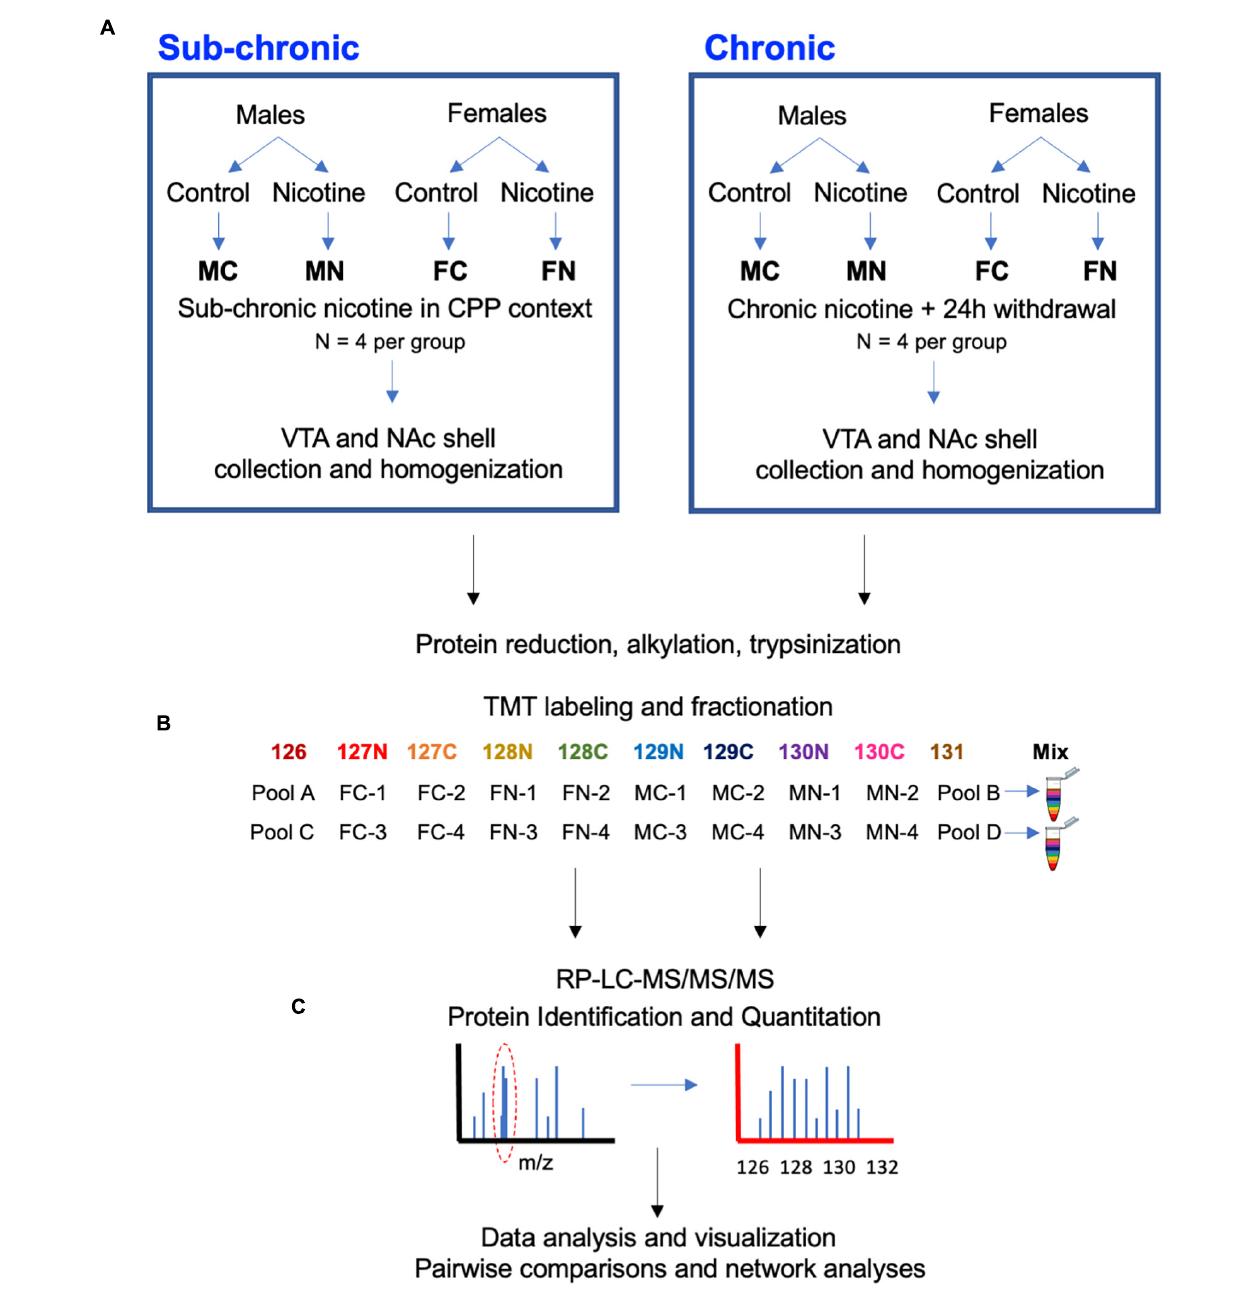
FIGURE 1 | Experimental design and workflow. (A) Male and female mice were treated with nicotine or control solutions. In C3H/HeJ mice, sub-chronic nicotine or saline was administered subcutaneously on alternating days for a total of 6 days in a CPP testing paradigm ( n = 4 per group). In C567BL/6J mice, nicotine or saccharin was administered in drinking water chronically for 21 days, followed by a 24-h withdrawal period ( n = 4 per group). About 10–30 min after CPP testing in C3H/HeJ mice, or 24 h after cessation of nicotine or saccharin treatment in C57BL/6J mice, subjects were sacrificed and the VTA and NAc shell were collected from each brain by 1 mm punch biopsy on 1 mm-thick coronal sections. (B) Tissue samples were subsequently processed for proteomic analysis with a TMT10-plex isobaric labeling strategy. (C) Data were quantified, normalized, analyzed, and visualized using MaxQuant and Perseus software and the online STRING database